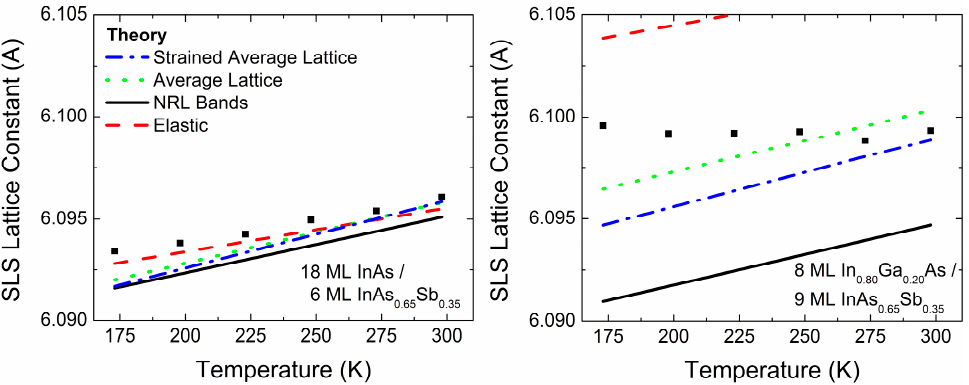
Figure 4. The Strained-layer superlattice (SLS) average out-of-plane lattice constant for InAs/InAsSb (left) and InGaAs/InAsSb (right). Measured values are shown as squares. Various theoretical values are given based on material models from Adachi (elastic and average lattice methods) as well as Vurgaftman.